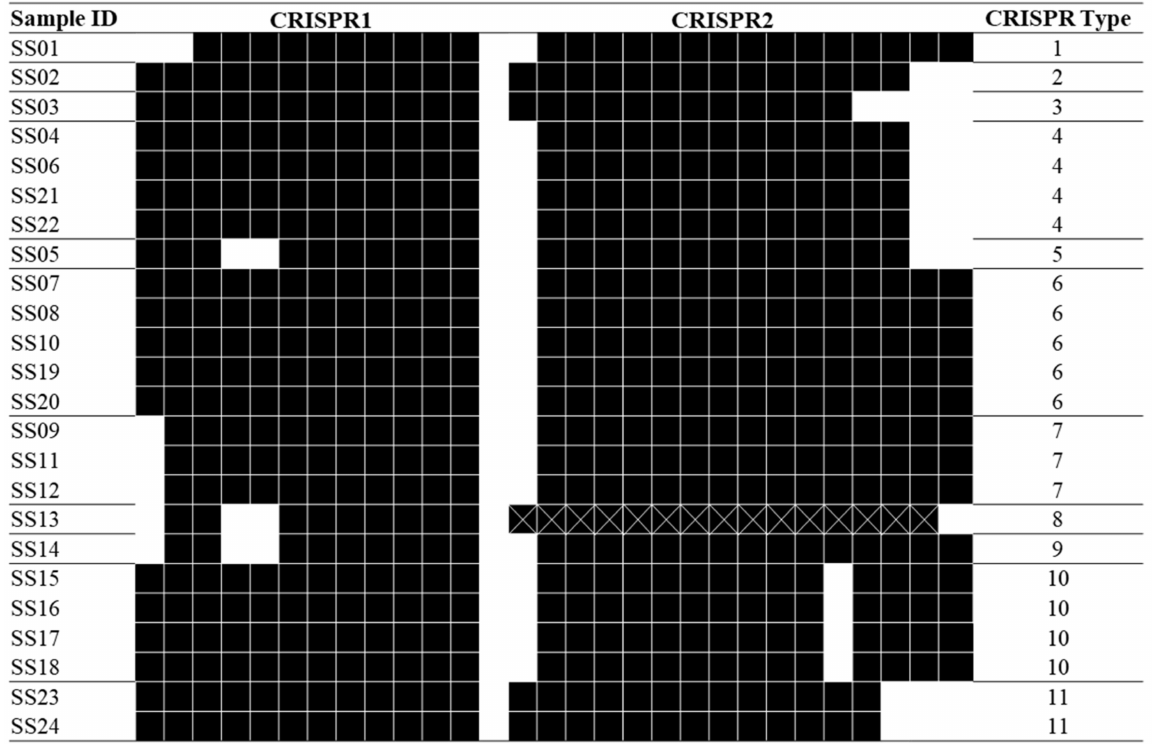
Figure 2. CRISPR spacer content of 24 S. enterica serovar Schwarzengrund isolates (11 types; DI = 0.906). Each unique spacer composition defines an allele, and a combination of CRISPR1 and CRISPR2 alleles was manually assigned an arbitrary CRISPR Type. Identical spacers shared between isolates under the same columns are shown as solid rectangles. Empty areas indicate that the corresponding spacer is not present in other similar patterns.